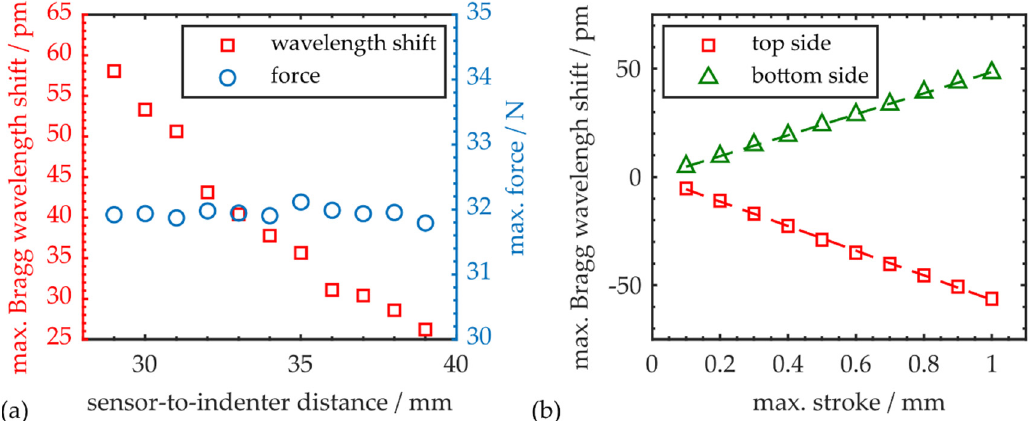
Figure 8. ( a ) Absolute maximum Bragg wavelength shift and force for maximum deflections of 0.5 mm at various sensor-to-indenter distances; ( b ) Sensor signal as a function of maximum stroke for both workpiece orientations, which means the Bragg grating is positioned near the specimen’s top or bottom side, respectively.